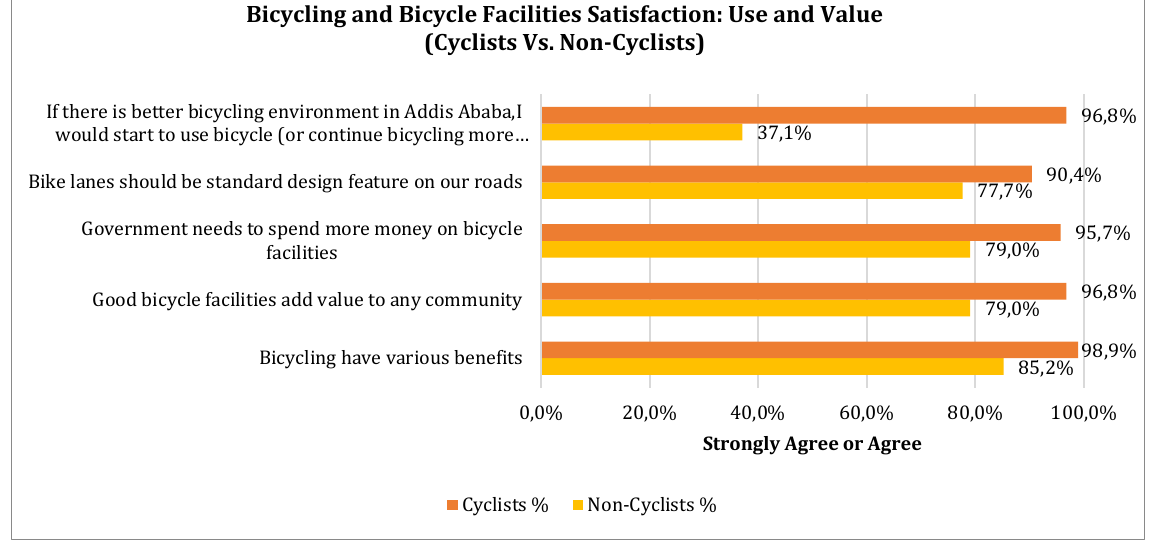
Figure 3: Bicycling and bicycle facilities satisfaction: Use and value (cyclists vs.